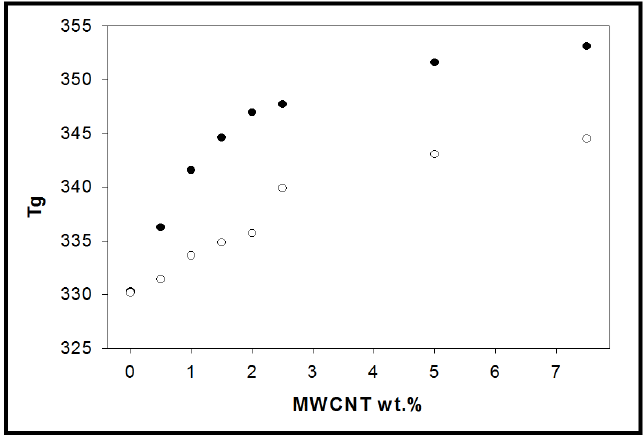
Figure 6. Glass transition temperature (T g ) variation with CNT loading in Ar-CNT-P ( ○ ) and Ar-CNT-C (●) composites.